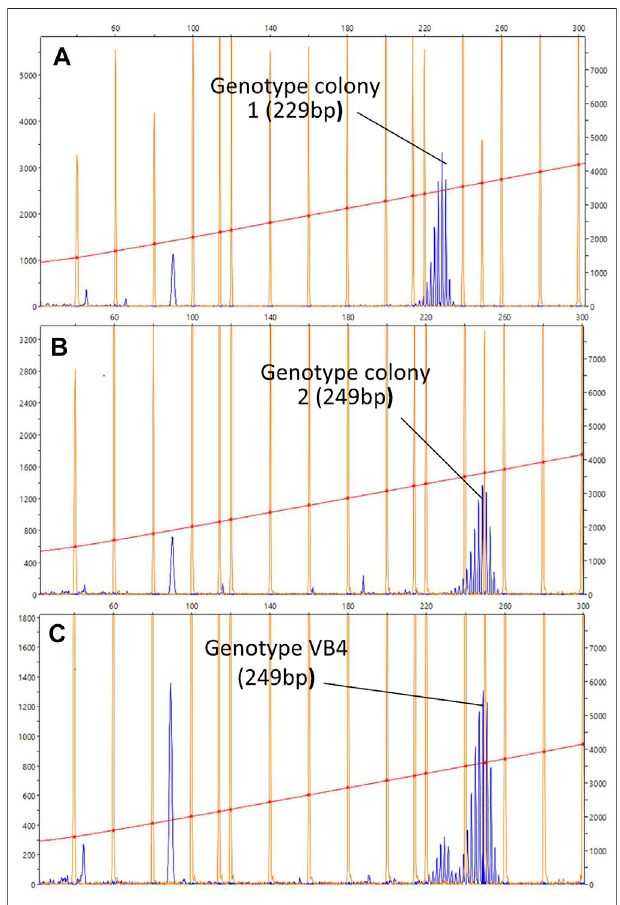
FIGURE 6 | Representative chromatogram for the microsatellites BS811. (A – C) Diagrams showing the size of the BS811 microsatellite locus ampli fi ed by PCR. The horizontal axis indicates the size in nucleotides and the vertical axis indicates the intensity of the fl uorescence detected in the PCR product. The size is calculated with the default settings of the Peak Scanner software for the referenced standard size used in this experiment, LIZ600 (blue peaks = fl uorescence of PCR products; orange peaks = standard size markers). Size of the fl uorescence peak detected in the PCR carried out with the gDNA of colonies 1 (A) and 2 (B) , collected before the fusion, and (C) with the gDNA obtained from the stomach of a vascular bud, developed in the colony vascular system 2. The size is given in nucleotides. The peak at less than 100 bp could indicate other alleles for the same locus, but since the size of this microsatellite is normally between 200 and 300 bp, it is most likely a non-speci fi c ampli fi cation product.